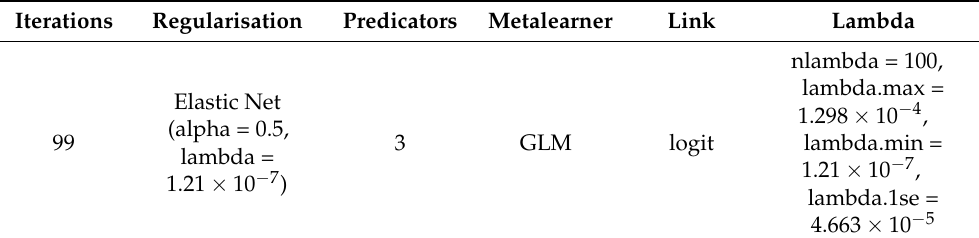
Table 3. H2O stacked ensembles parameters.